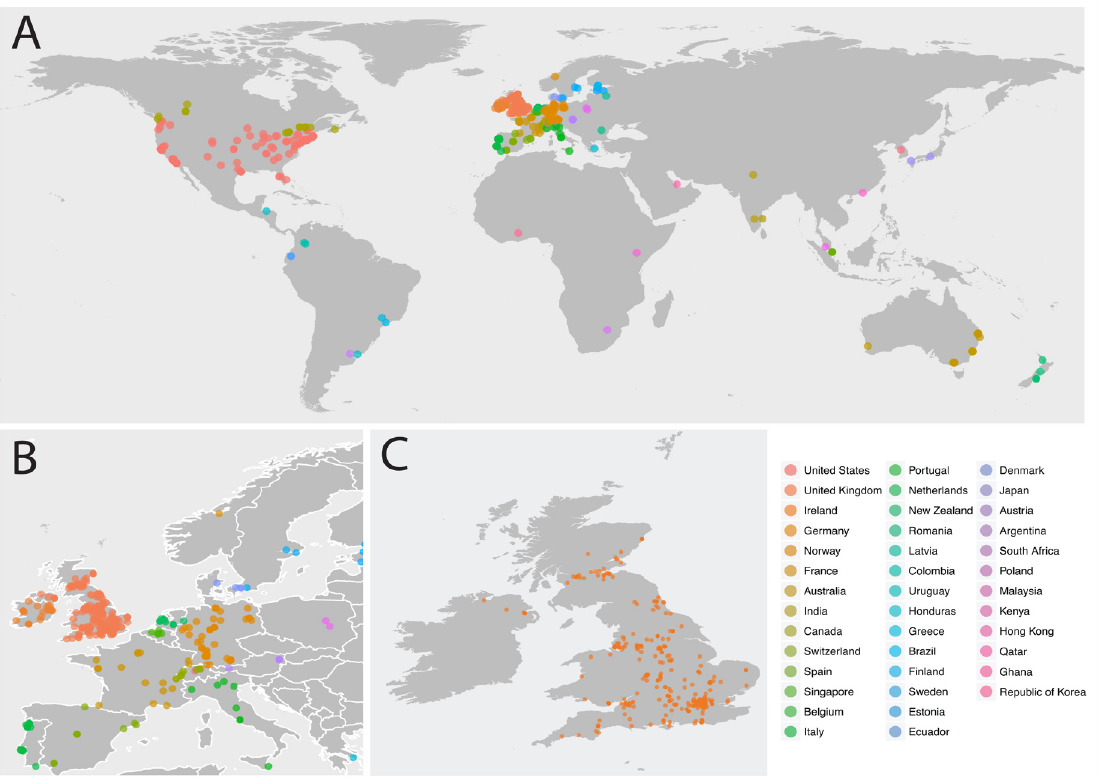
Figure 1. Distribution of responses based on geolocation of IP address. Each point shows a single IP address and points are coloured by country. A shows IP addresses on a global map, whereas B and C show distributions across Western Europe ( B ) and the United Kingdom ( C ). Country boarders are shown as white lines in A and B